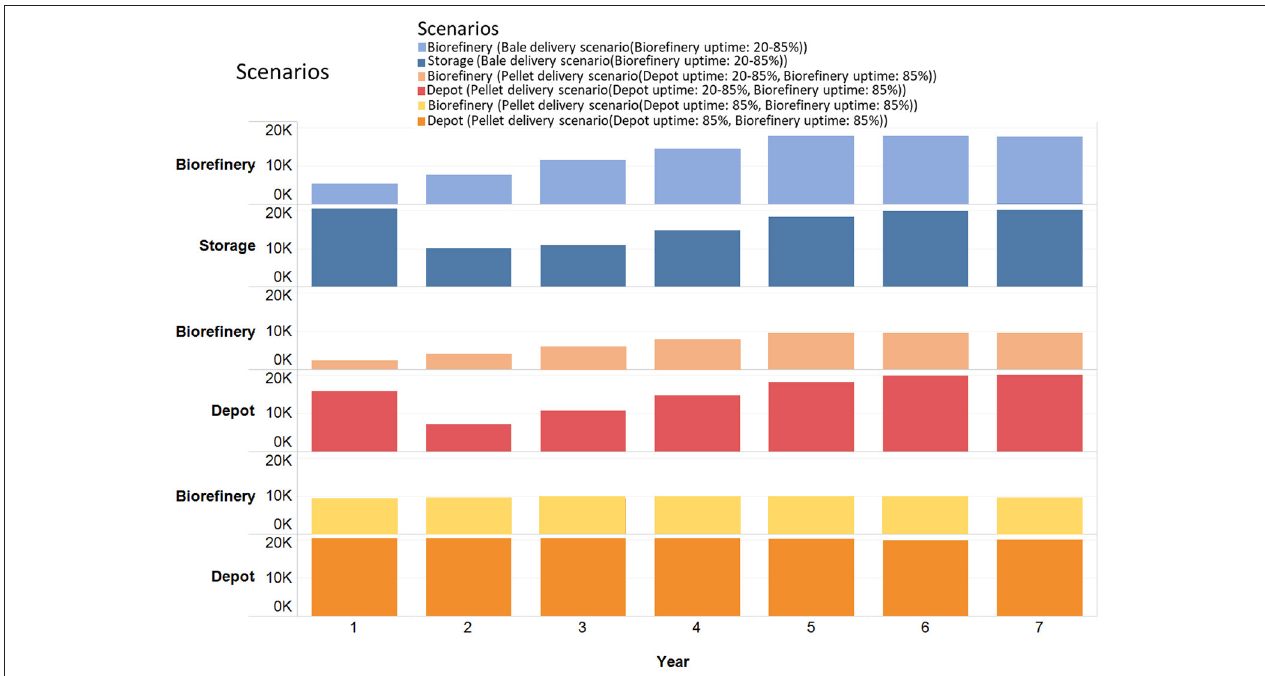
FIGURE 8 | Total corn stover trucks delivered to intermediate sites (storage/depot) and biorefinery for the bale-delivery (Biorefinery uptime: 20–85%), pellet-delivery (Depot uptime: 20–85%, Biorefinery uptime: 85%) and pellet-delivery (Depot uptime: 85%, Biorefinery uptime: 85%)